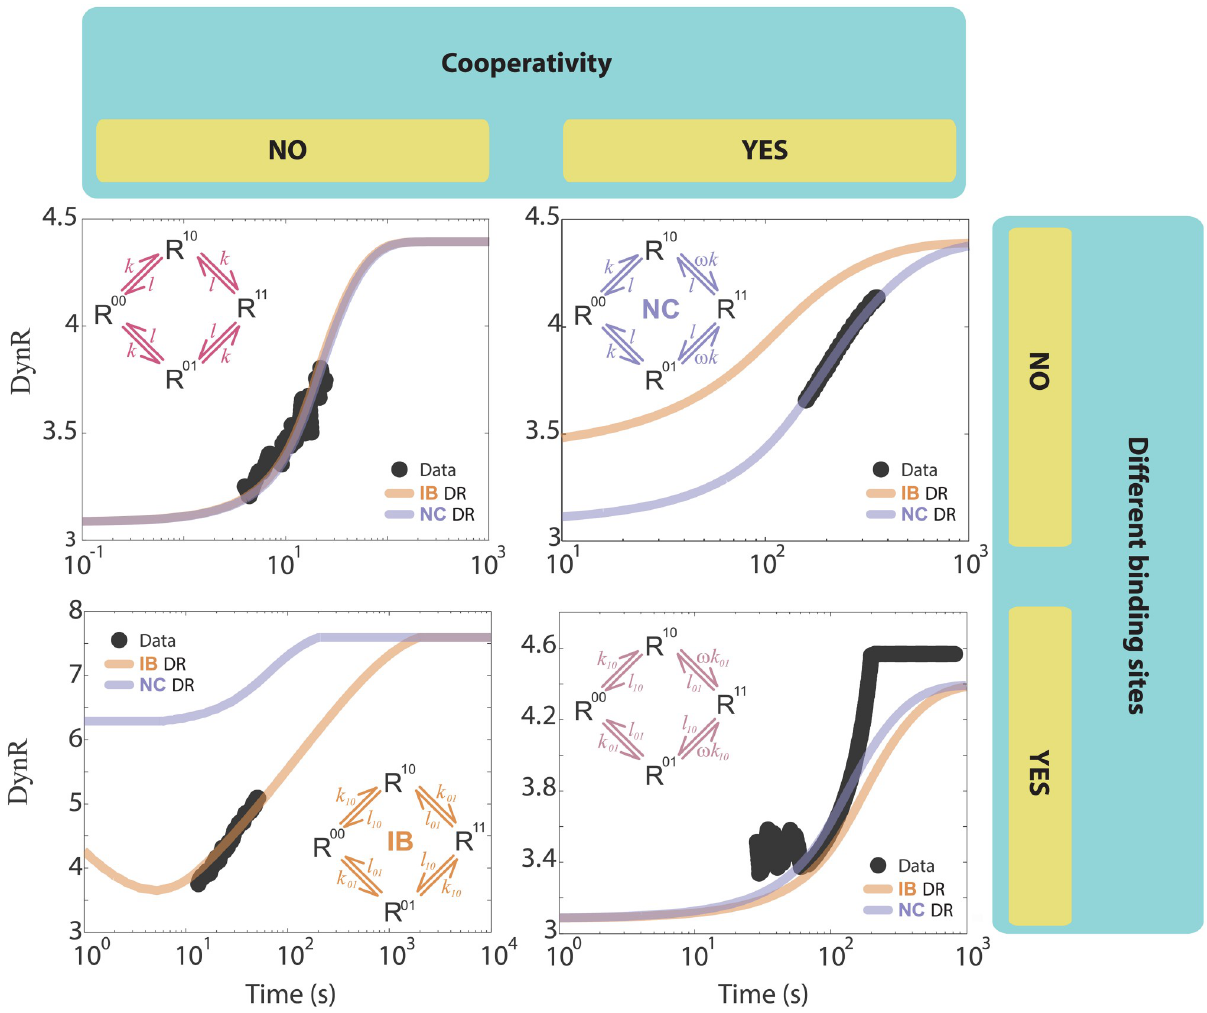
Fig 7. TC + DR algorithm applied to experimental data. The two binding sites space is divided in four: left/right panels do not have/have cooperativity, upper/lower panels do not have/have different binding sites. In all four panels DynR vs. time is plotted, filled dots are the data, indigo/ brown solid line is the DynR expected from the NC / IB model. Schemes with the microscopic models are superimposed in each panel. Up and left , data from a one site model, both curves ( DynR from NC and from IB ) are the same and fit the data. Up and right , NC experimental data, bottom and left , IB experimental data (details of the steps and checkpoints applied to these two datasets are in Fig G in S1 Text). Bottom and right , data from a two different sites binding experiment with positive cooperativity, neither NC nor IB fit the data, as expected. In the NC example, time goes from 0 to 700 s with a step of 0.1; ligand goes from 0.01 to 3 μ M, with a non-uniform step totalizing 13 doses (0.01, 0.05, 0.075, 0.1, 0.15, 0.2, 0.3, 0.5, 1, 1.5, 2, 2.5, 3 μ M). In the IB example, time goes from 0 to 500 s with a step of 0.1; ligand goes from 3.9 to 2000 nM, each dose is the double of the previous one totalizing 10 doses. In the up and left example, time goes from 0 to 40 s with a step of 0.025; ligand goes from 0.1 to 25.6 μ M, each dose is the double of the previous one, totalizing 9 doses. In the bottom and right example, time goes from 0 to 250 s with a step of 0.025; ligand goes from 0.7 to 200 nM, each dose is approximately 1.85 times the previous one, totalizing 10 doses. Parameters obtained from the fits and compared with those in the articles where the data comes from are included in Table